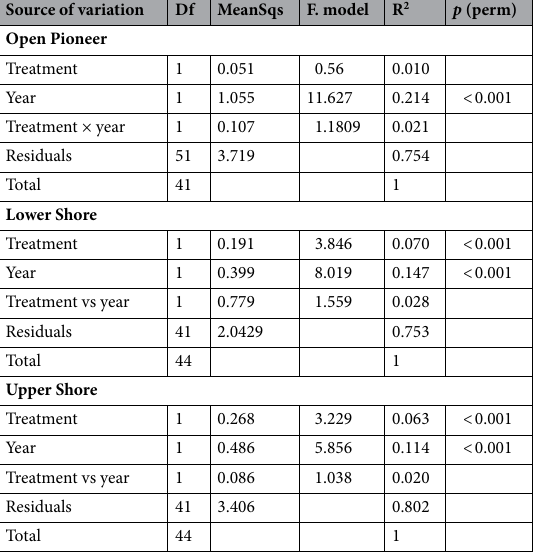
Table 1. PERMANOVA results based on Bray–Curtis dissimilarity from species importance values obtained from the mean percentage cover (n = 3). The results show the effects of experimental factors on plant community composition (August of 2018, 2019 and 2020).